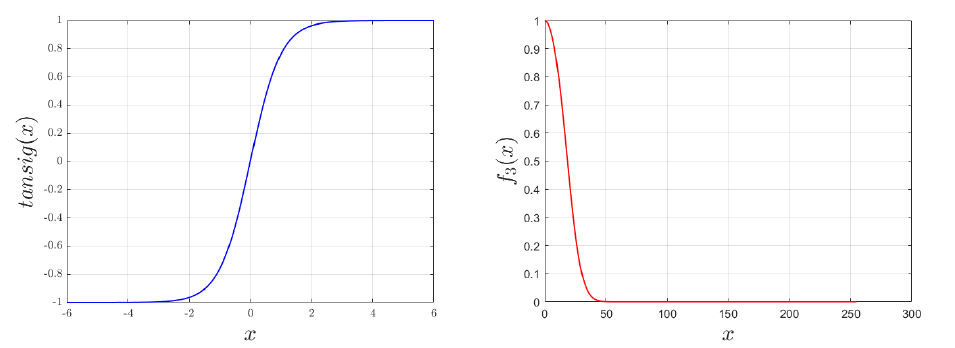
Figure 2. Curves of Tansig and f 3 coefficient